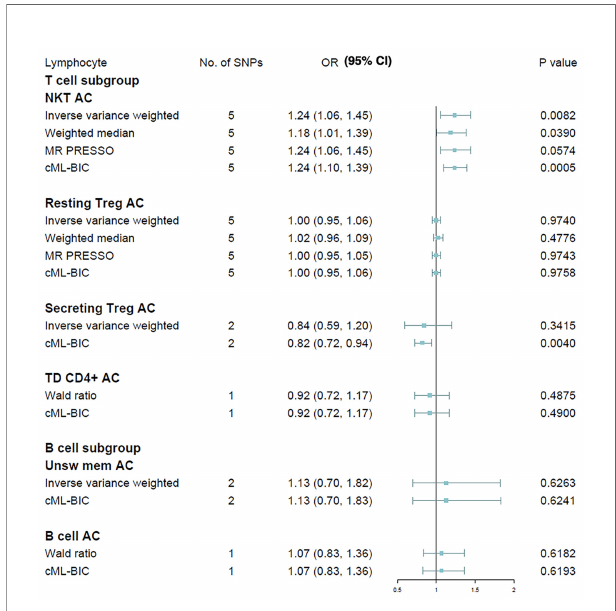
FIGURE 2 | Mendelian randomization estimates of the association between blood cell counts and risk of multiple sclerosis. OR, odds ratio; CI, con fi dence